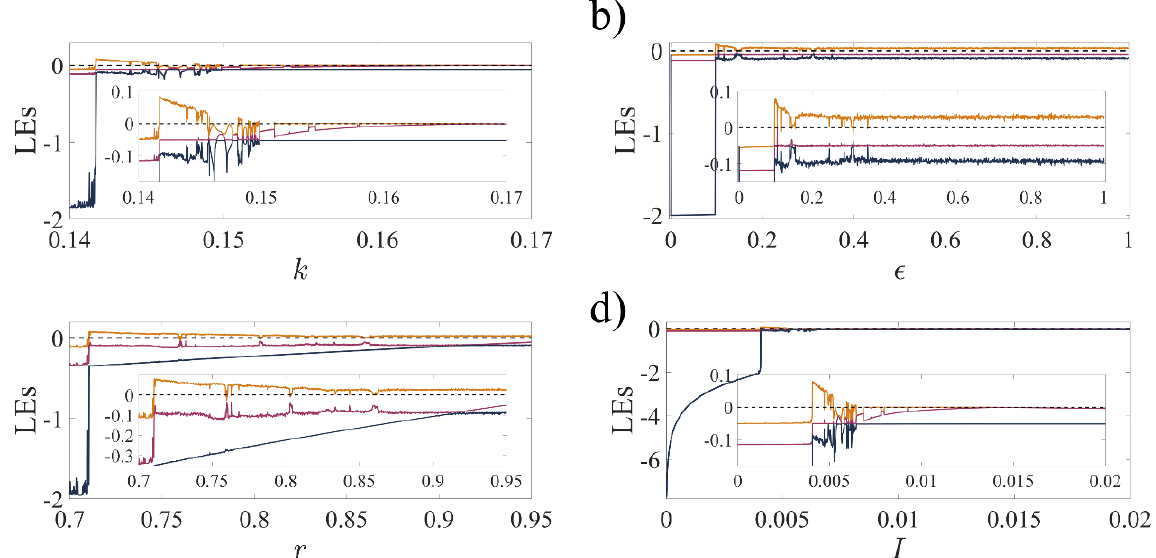
Figure 3. The Lyapunov exponents (LEs) of 3D-MCM as a function of system parameters: ( a ) the magnetic strength, 𝑘 ; ( b ) the scale factor of time, 𝜖 ; ( c ) the scale factor of flux, 𝑟 ; and ( d ) the injected ion current, 𝐼 . The parameters are the same as in Figure 1. The initial condition is (𝑥(0), 𝑦(0), 𝜙(0)) = (1.0, 0.8, 0.2) . In each panel, the largest exponent is displayed in yellow, while the two smaller ones are displayed in red and dark blue.